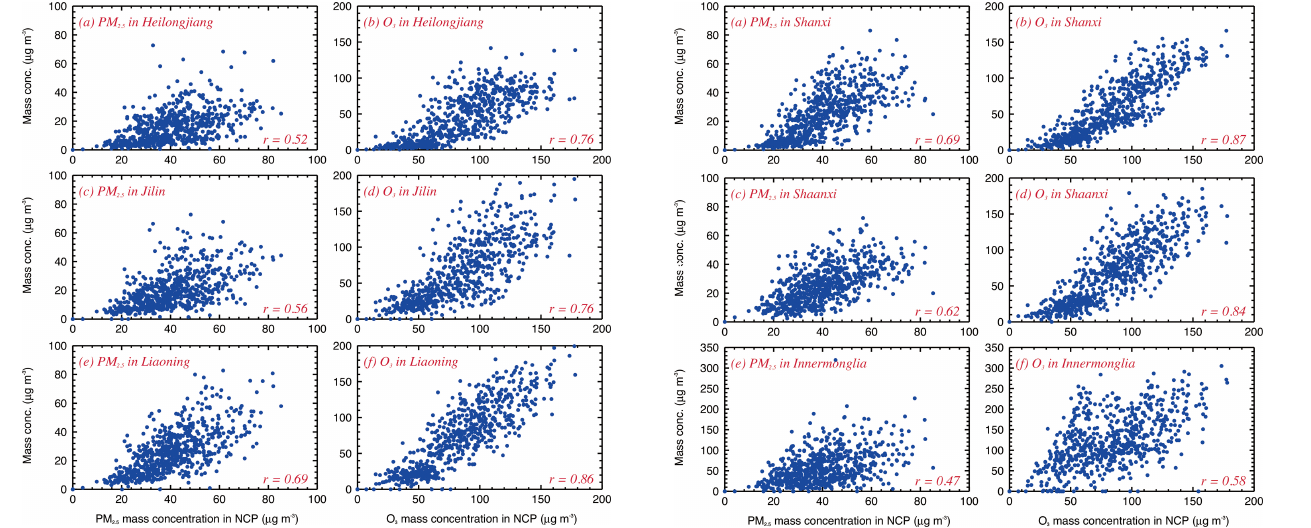
Figure 4. Same as Fig. 3, but for